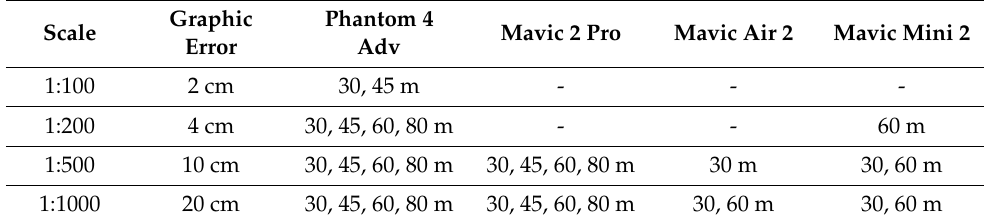
Table 13. Planimetric graphic errors when performing flights at different AGLs.